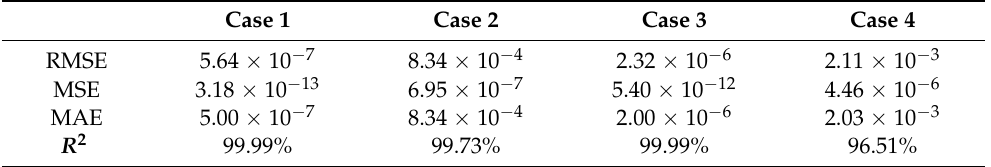
Table 2. Overall evaluation of Case 1–Case